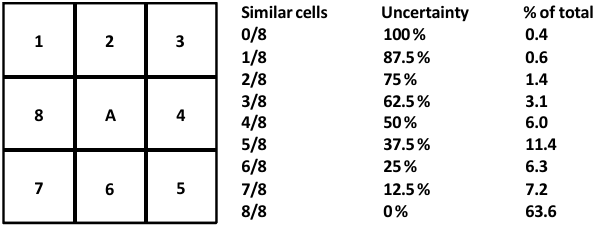
Figure 6. Geography map uncertainty is assessed by a 3 × 3 mov- ing window. The central grid cell A is assessed for uncertainty based upon the values of the surrounding eight grid cells. If no surround- ing cells equal the value of the central cell, then the uncertainty on the central cell is 100%. After assessment of one cell, the 3 × 3 window moves to assess the next cell until all cells are assessed. The accompanying table gives cell matches, resulting uncertainties, and percentage of land cells that fit each